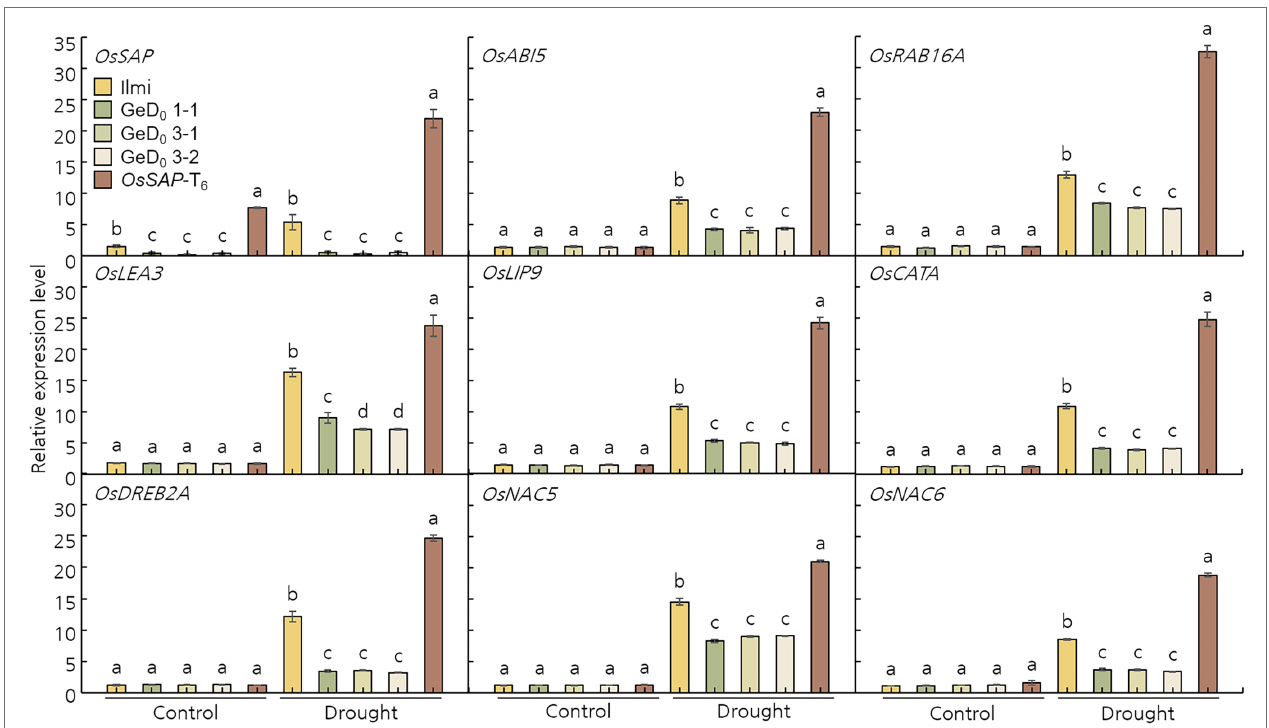
FIGURE 5 | Oryza sativa Senescence-associated protein is involved in the expression levels of several critical stress-related transcription factors under drought conditions. Under normal conditions OsABI5 , OsRAB16A , OsLEA3 , OsLIP9 , OsCATA , OsDREB2A , OsNAC5 , and OsNAC6 expression levels were the same. However, overexpression of OsSAP under drought conditions improved the expression levels of the evaluated stress-related transcription factors. Bars represent mean ± SE. Means denoted by the same letter are not significantly different ( p < 0.05) as evaluated by Duncan’s multiple range test. Different letters on columns represent significant ( p < 0.05) difference between rice lines based on Duncan’s